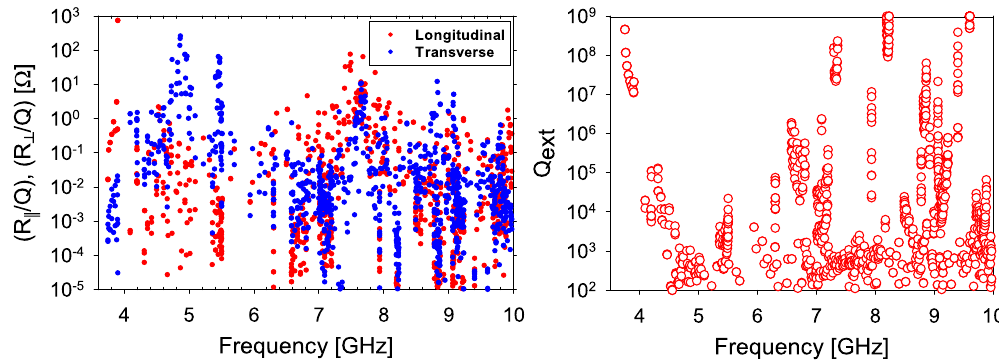
FIG. 5. HOM shunt impedances (left) and external quality factors (right) in the ideal 3.9 GHz LCLS-II